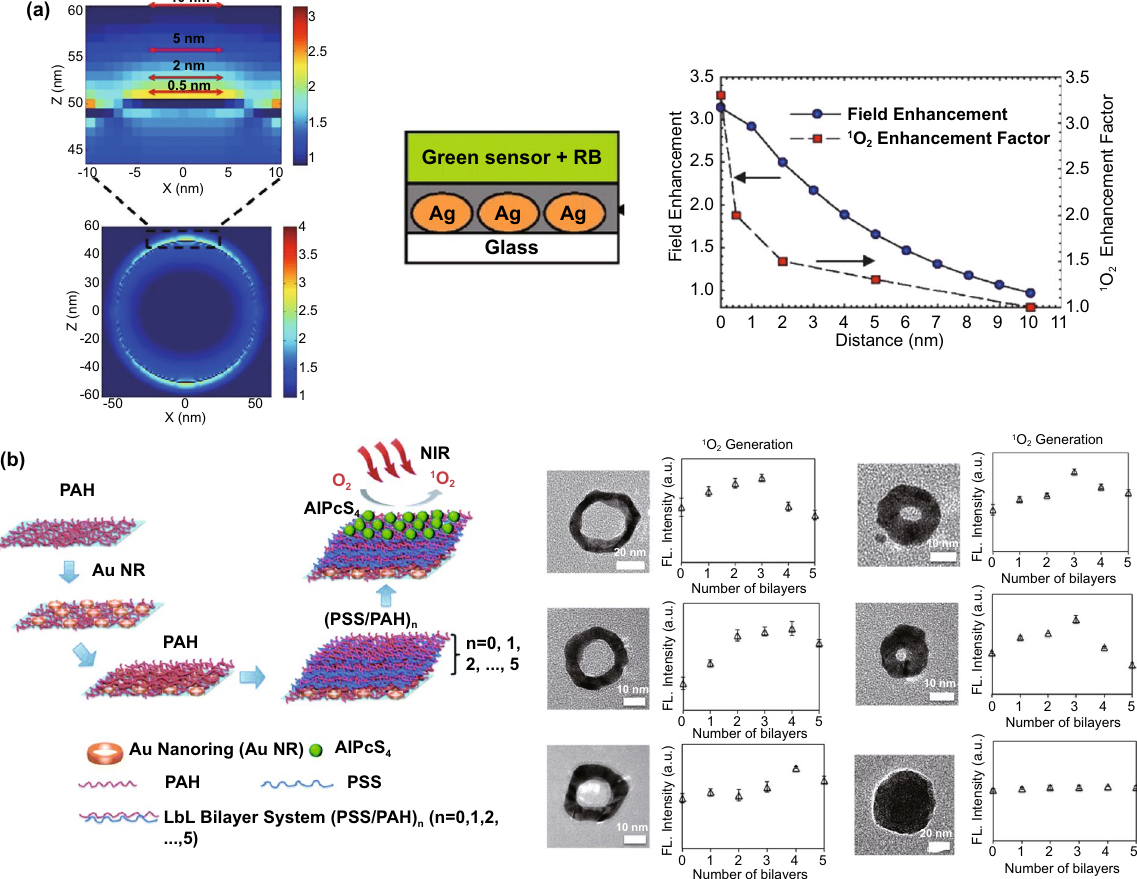
Fig. 11 a Distance-dependent of ME-SOG for Rose Bengal on silver island film coated with silica layer as a spacer, reproduced from Ref. [17] with permission from National Academy of Sciences. b Distance-dependent of ME-SOG for AlPcS 4 on glass substrate containing Au nanoring coated with different PAH/PSS bilayers, reproduced from Ref. [181] with permission from Royal Society of